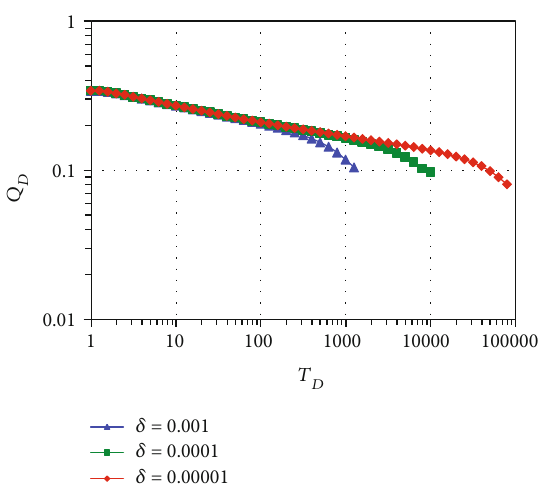
Figure 15: Dimensionless productivity curve under di ff erent degrees of mud pollution.